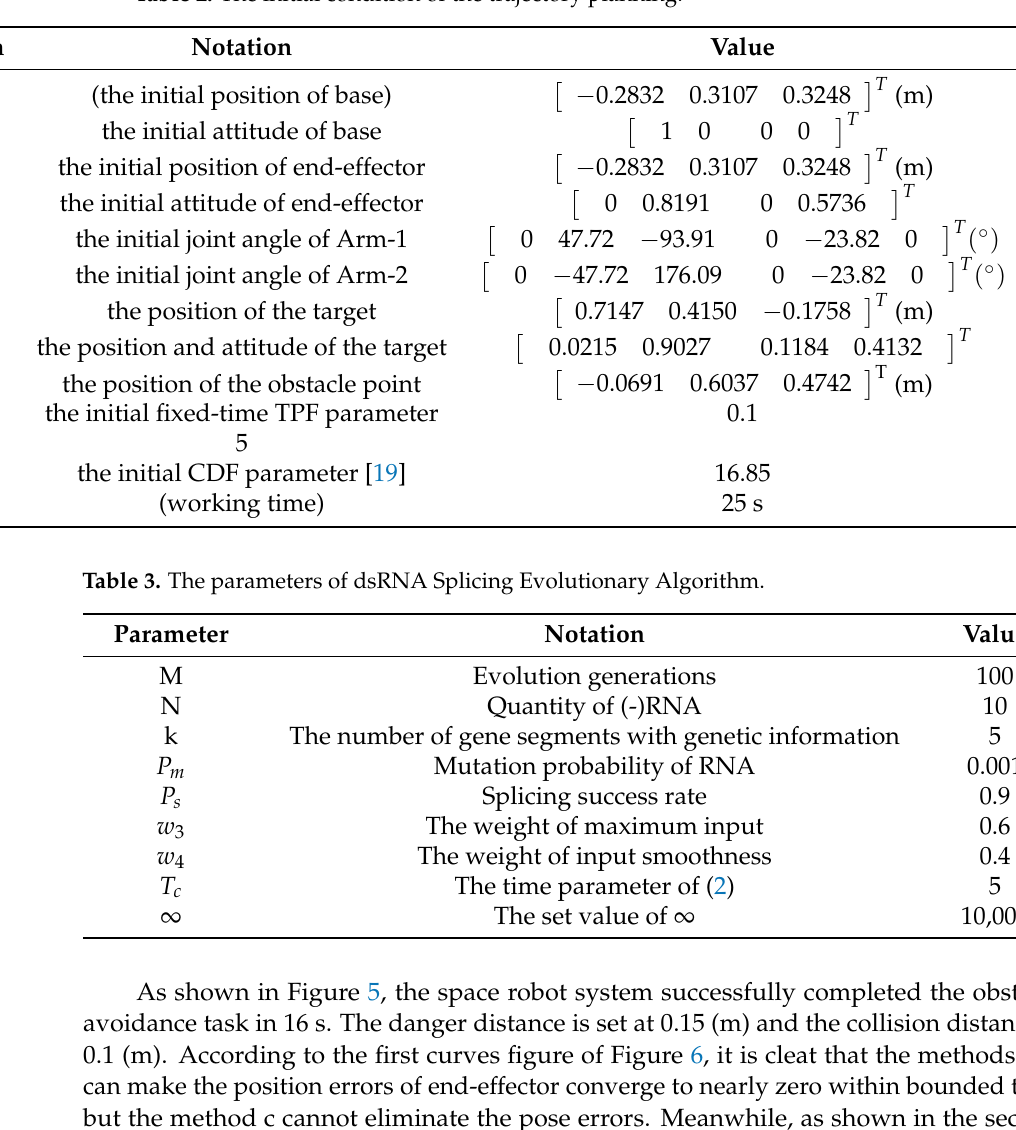
Table 2. The initial condition of the trajectory planning.